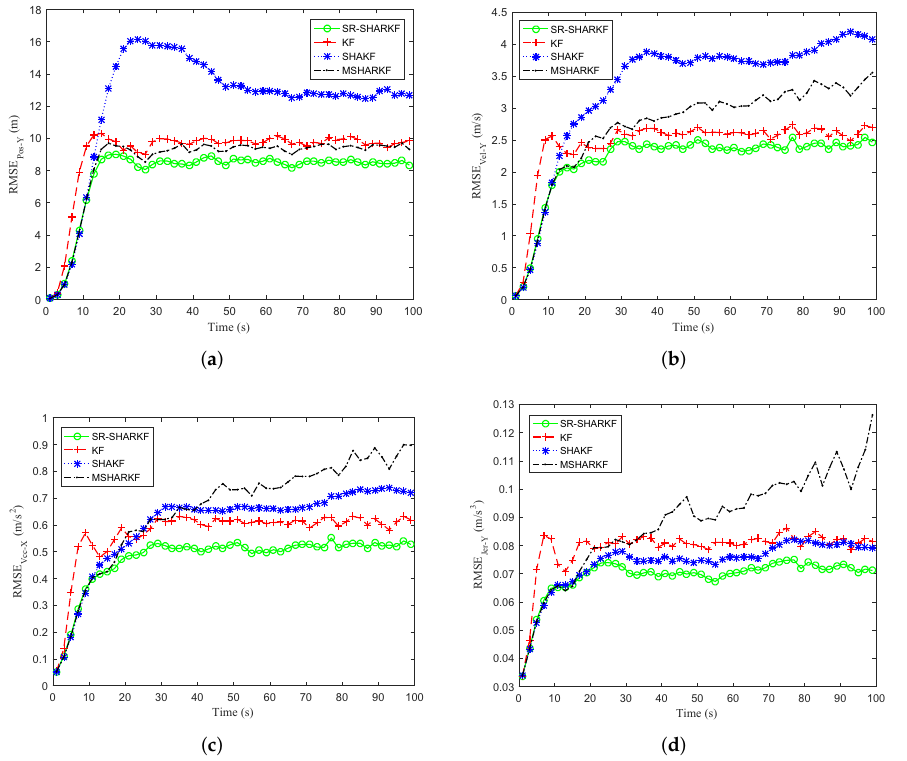
Figure 11. Dynamic parameter RMSE in the Y-axis direction. ( a ) Position RMSE. ( b ) Velocity RMSE. ( c ) Acceleration RMSE. ( d ) Jerk RMSE.